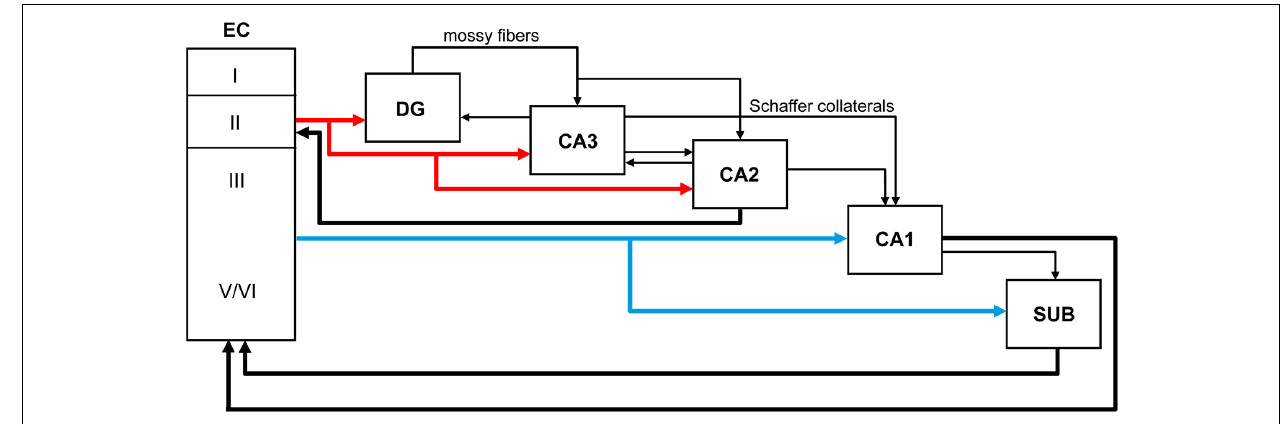
FIGURE 1 | Schematic diagram showing the main perforant pathway projections to the hippocampus and the main connections between the dentate gyrus (DG), CA fields, subicular complex (SUB), and entorhinal cortex